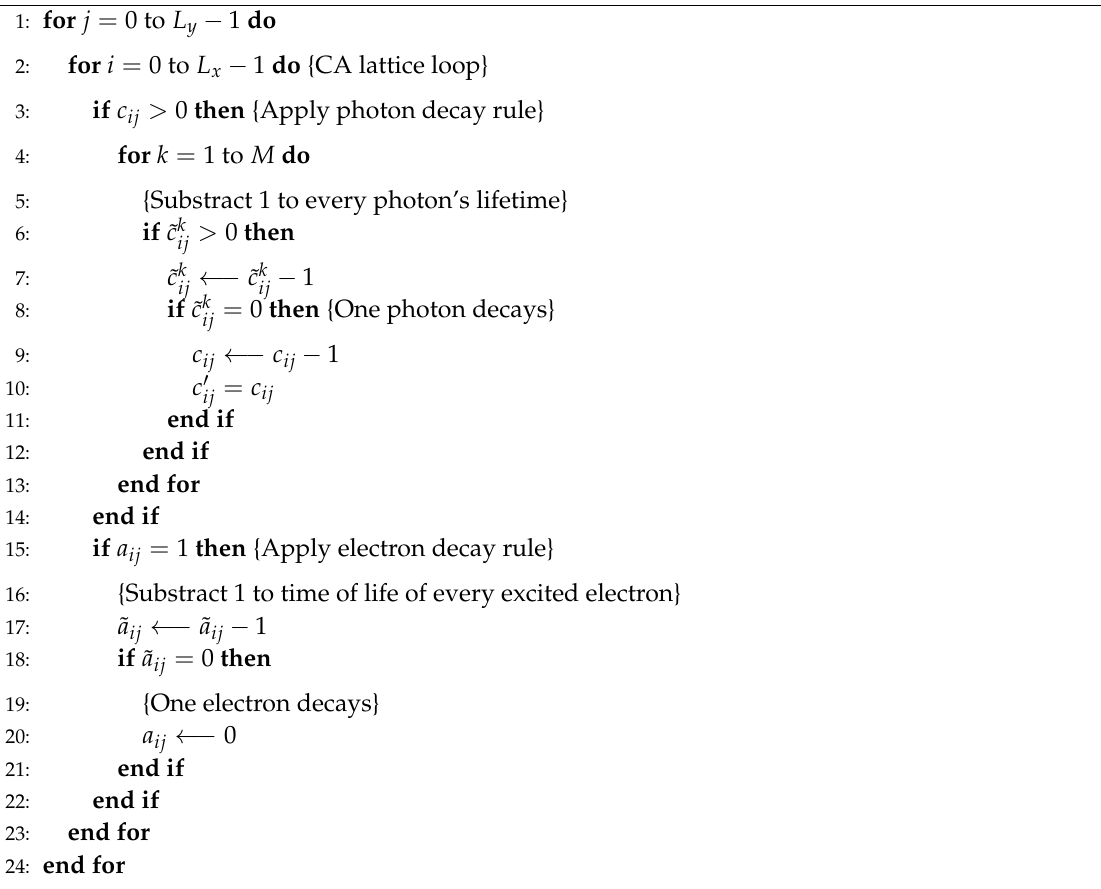
Algorithm 3 Pseudo code diagram for the implementation of the photon and electron decay and evolution of temporal variables’